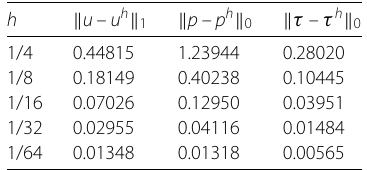
Table 3 The illustration of the error for the Oseen viscoelastic fluid flow with stabilization term for the FE p 1 – p 1 – p 1 dg